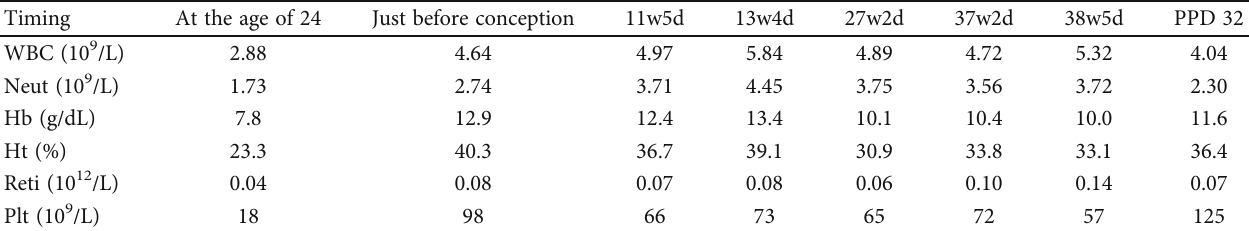
Table 1: The changes in maternal complete blood counts.